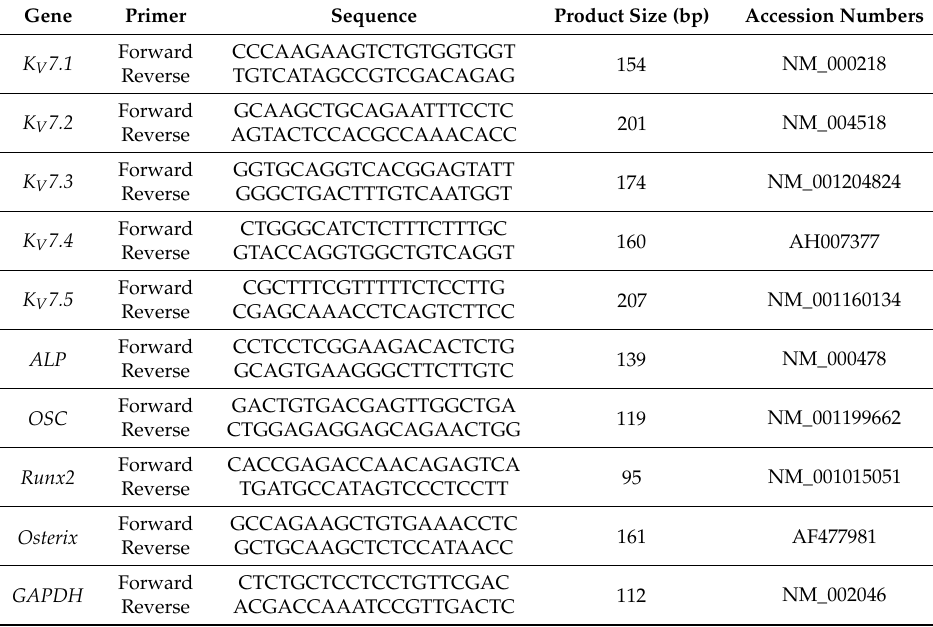
Table 1. Sequences of PCR primers used for RT-PCR and quantitative